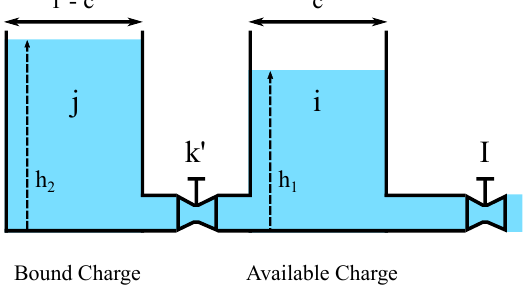
Figure 2. Kinetic Battery Model (KiBaM)